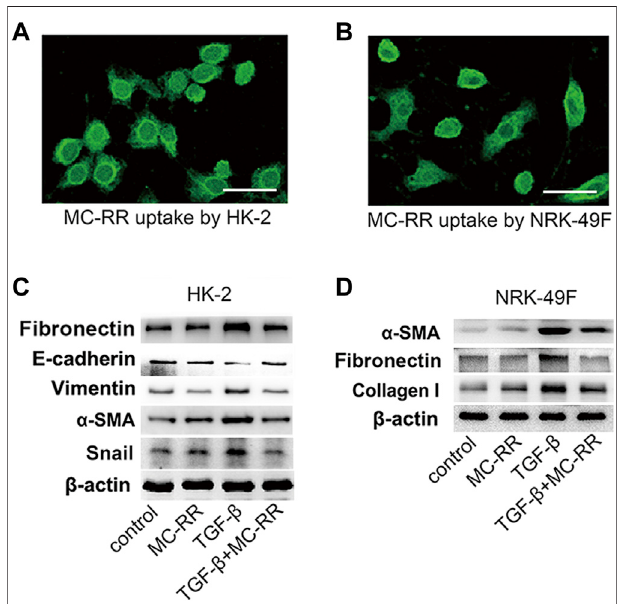
FIGURE 3 | Microcystin (MC)-RR inhibits TGF- β -induced epithelial dedifferentiationandmyo fi broblastdifferentiation invitro. (A,B) Cultured HK2 (human proximal tubular cell) and NRK-49F (rat kidney fi broblasts) were treatedwithMC-RR(0.1 μ M)for48 h.TheuptakeofMC-RRbyHK2and NRK-49F cells was detected by immuno fl uorescence (scale bar: 40 μ m). (C,D) HK2 and NRK-49F cells were left alone or cultured with TGF- β 1 (5 ng/ ml) to induce epithelial dedifferentiation and myo fi broblast activation. Some of the cultured cells were also treated with 0.1 μ M MC-RR for 48 h. The expression levels of the marker proteins used for assessment of epithelial dedifferentiation and myo fi broblast activation in the cultured HK2 or NRK-49F cells were detected by western